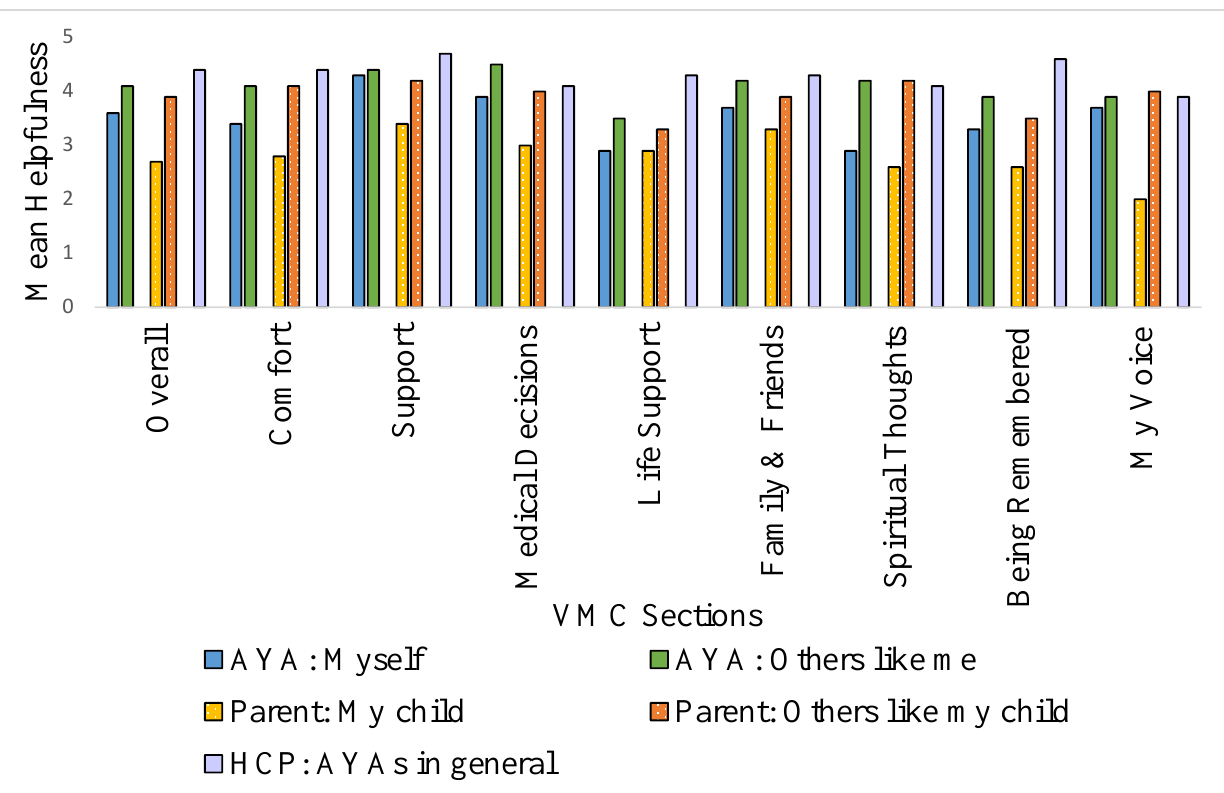
Figure 2. Helpfulness of VMC sections to oneself versus others like me (AYAs), and my child versus others like my child (parents), and AYAs in general (health professionals).